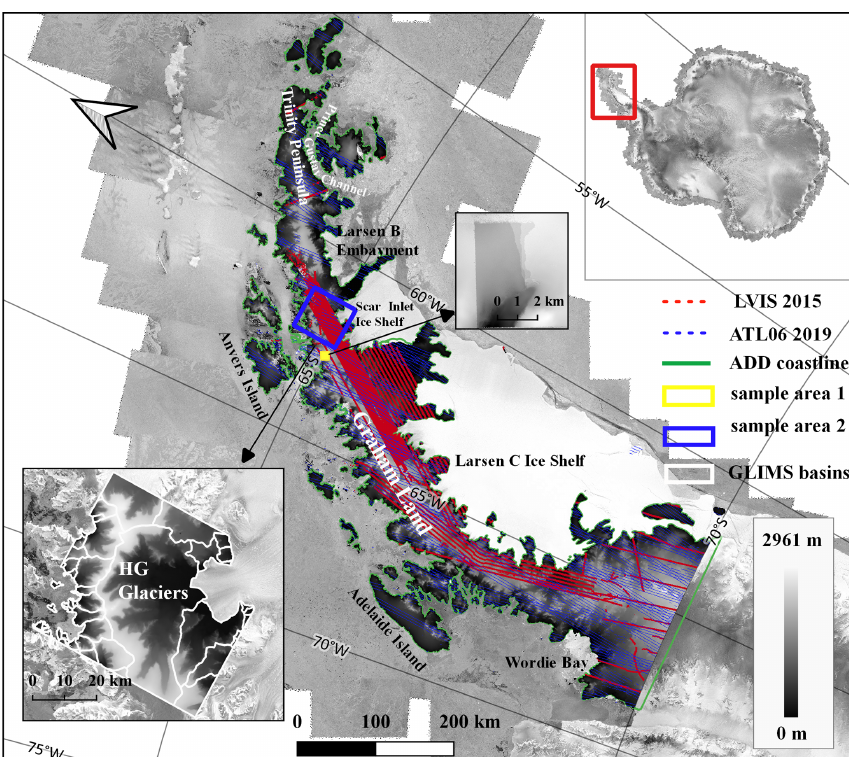
Figure 1. Experimental area and TanDEM-X DEM coverage over the Antarctic Peninsula. Dotted red and blue lines: the footprints of the LVIS 2015 and ATL06 2019 laser points, respectively. Green outline: the coastline mask from the Antarctic Digital Database (ADD). Blue and yellow boxes: sample areas of the experimental results corresponding to the two zoomed-in windows. White outline: glacier basins from GLIMS around Hektoria and Green (HG) glaciers. Background: RADARSAT-1 Antarctic Mapping Project (RAMP) imagery mosaic (Jezek, 1999; Jezek et al., 2013) from Quantarctica (Matsuoka et al.,